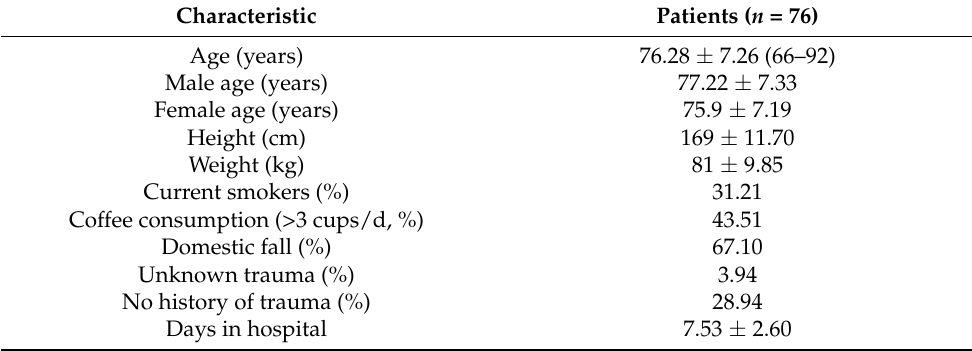
Table 1. Characteristics of the patients.